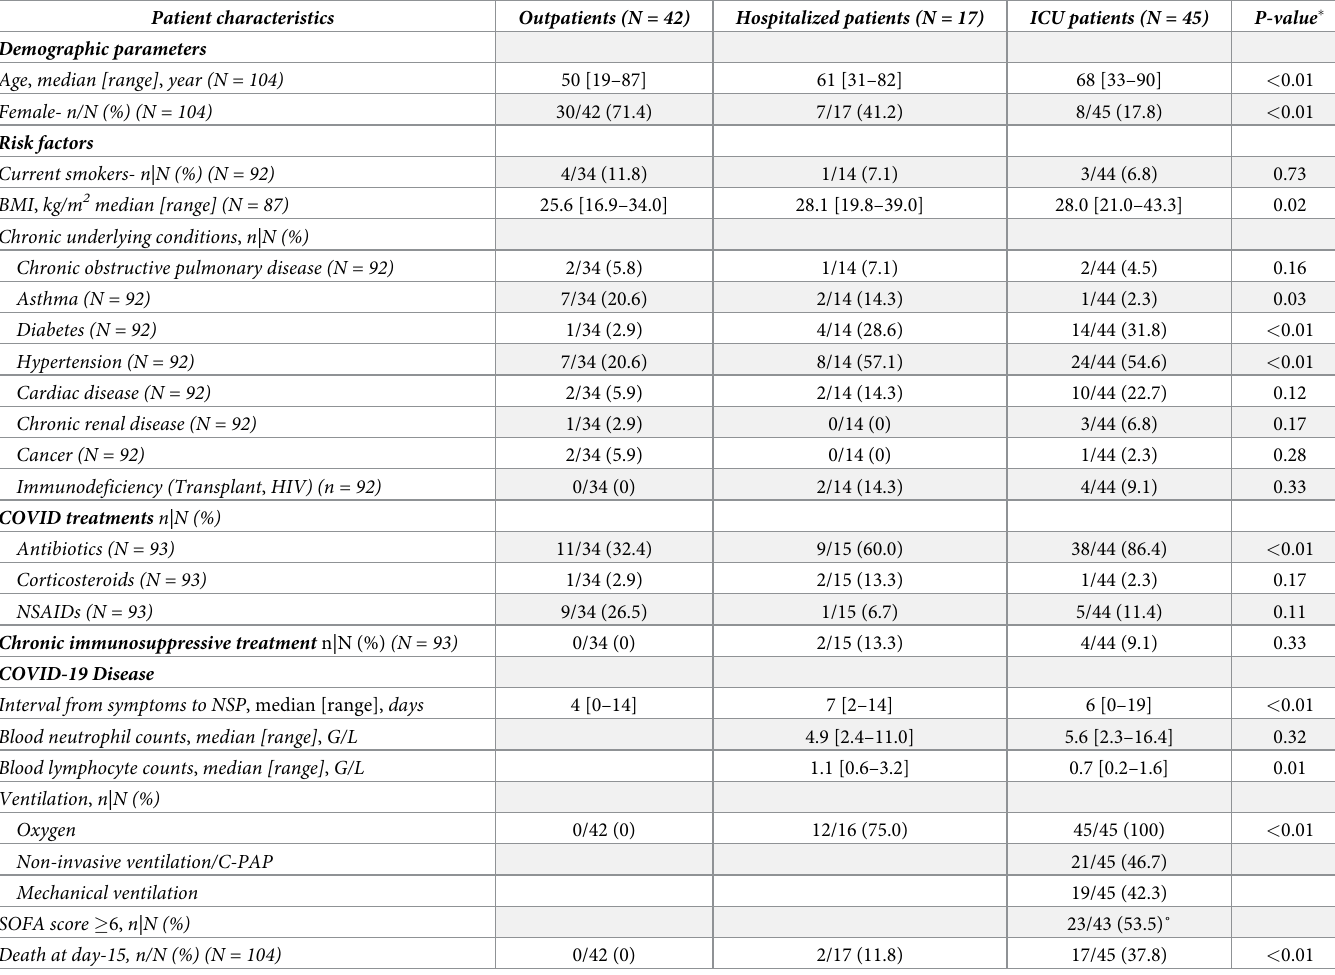
Table 1. Patient characteristics at the time of nasopharyngeal swab sampling.